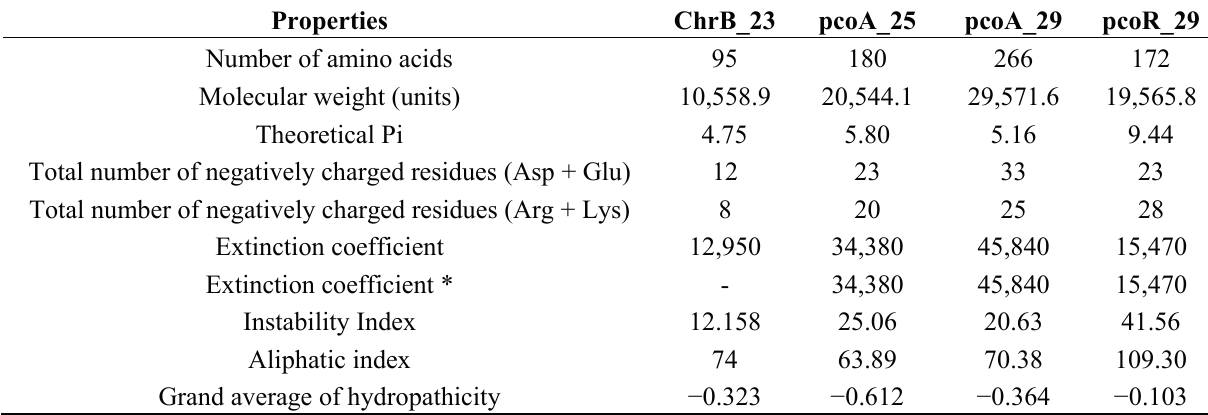
Table 1. Physicochemical properties of partial protein